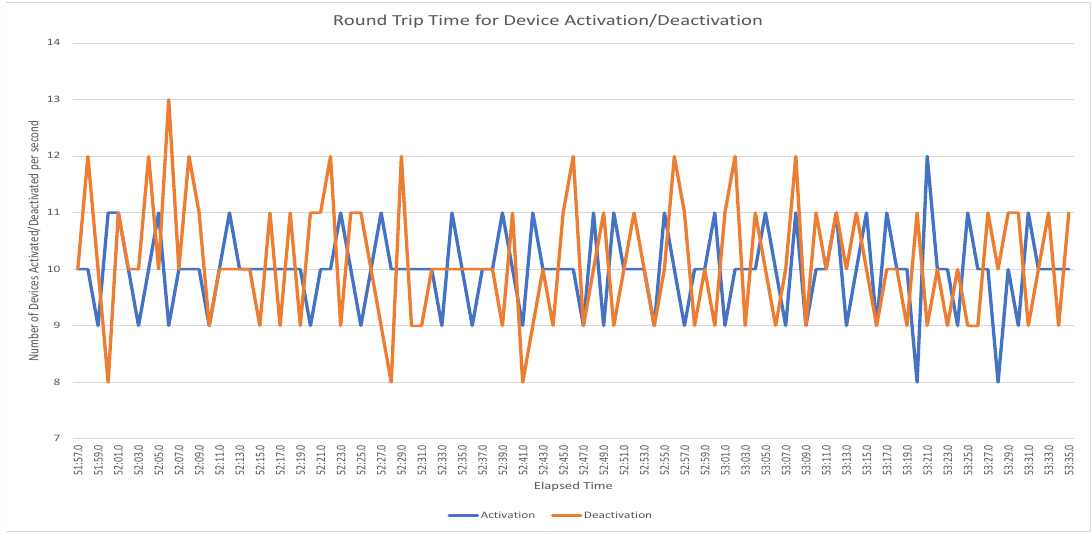
Figure 11. Round trip time for device